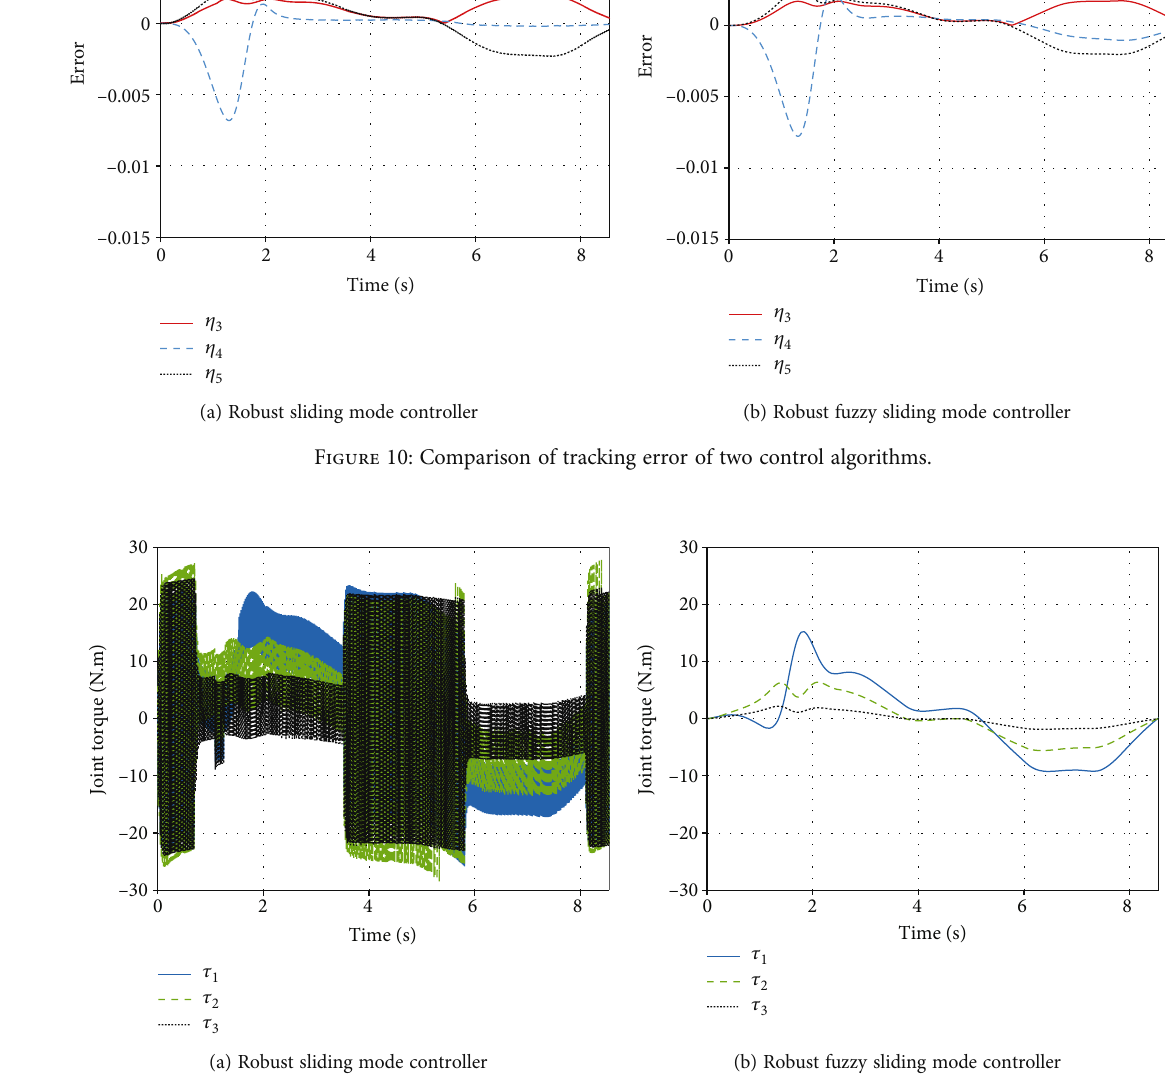
Figure 11: Comparison of joint control torque of the two control